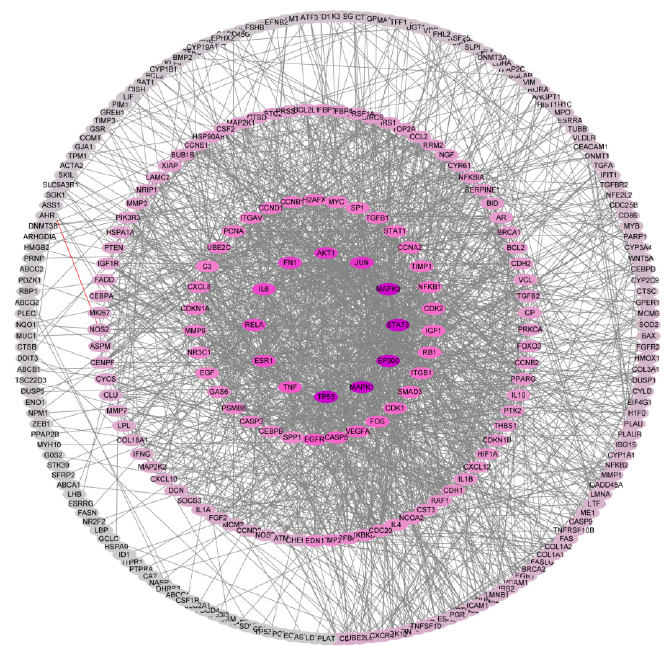
Figure 2. PPI network of the core genes in genistein’s action against human cervical cancer (dark purple color indicates high degree; grey color indicates low degree).